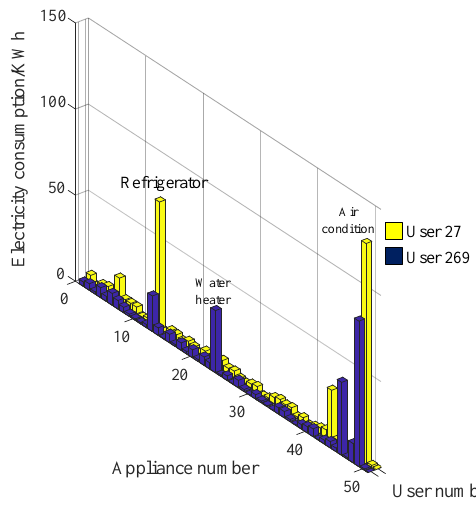
Figure 13. Comparison between users of the same type.